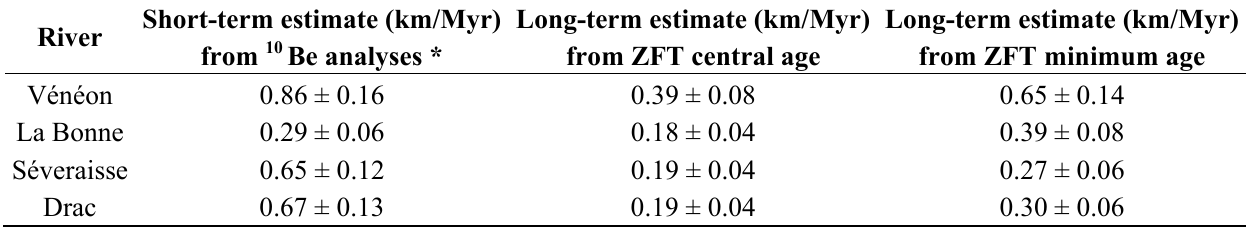
Table 3. Pelvoux massif short-term versus long-term erosion rate estimates.